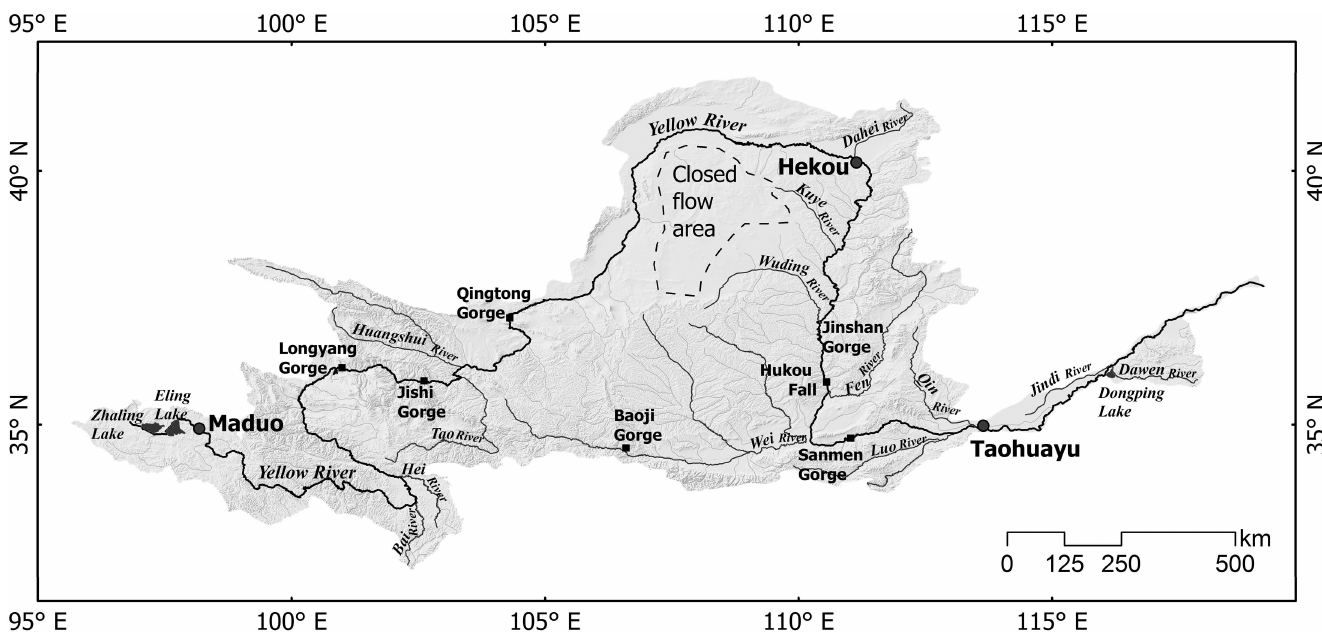
Fig 1. Topographic map of the Yellow River basin. The entire basin is dividedinto four parts, includingthe source (from head to Maduo), upper Yellow (from Maduo to Hekou), middleYellow (from Hekou to Taohuayu) and lower Yellow (from Taohuayuto the river mouth). There is a closed flow area in the Loess Plateau with no water exchangewith the Yellow